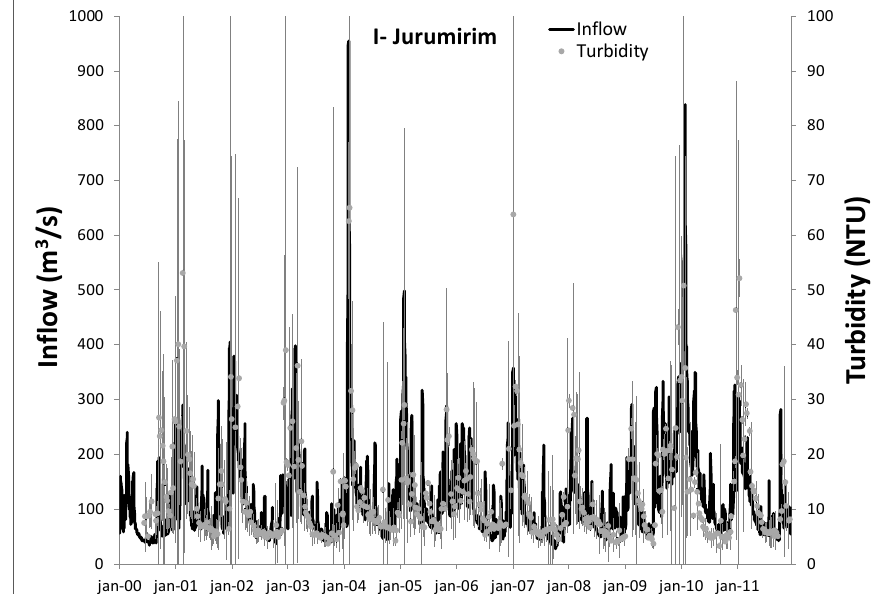
Figure 5. Variation of river discharge and remote sensing-retrieved turbidity in the tail zone of reservoir #I from 2000 to 2011.